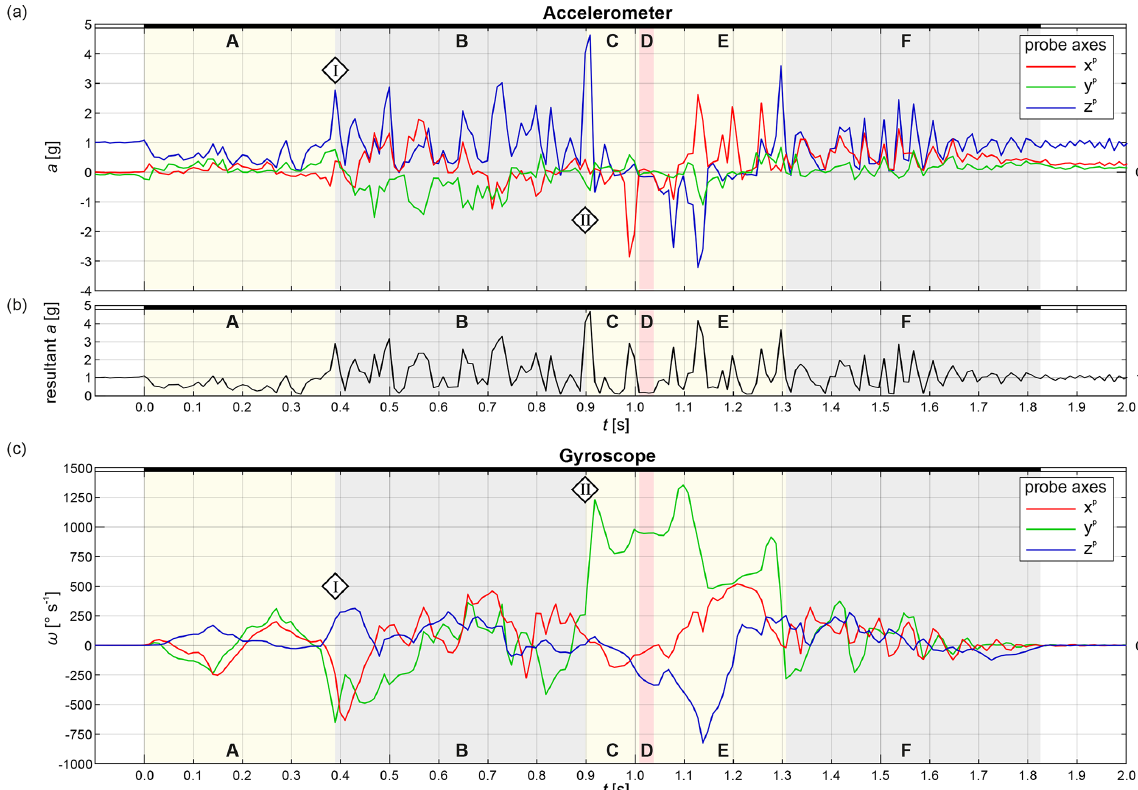
Figure 3. Calibrated sensor data of pebble 4. Data are plotted versus relative time since the start of motion. Stationary periods are indicated by white bars, and motion is indicated by a black bar at the top of each plot, respectively. Vertical bars in light yellow, grey and red mark particular phases (A–F) within the motion sequence (for description see text). Numbered diamonds indicate distinct points in time (see also Fig. 4). (a) ACC data, (b) resultant acceleration magnitude and (c) GYR data. Curves in (a) and (c) show recordings along and around